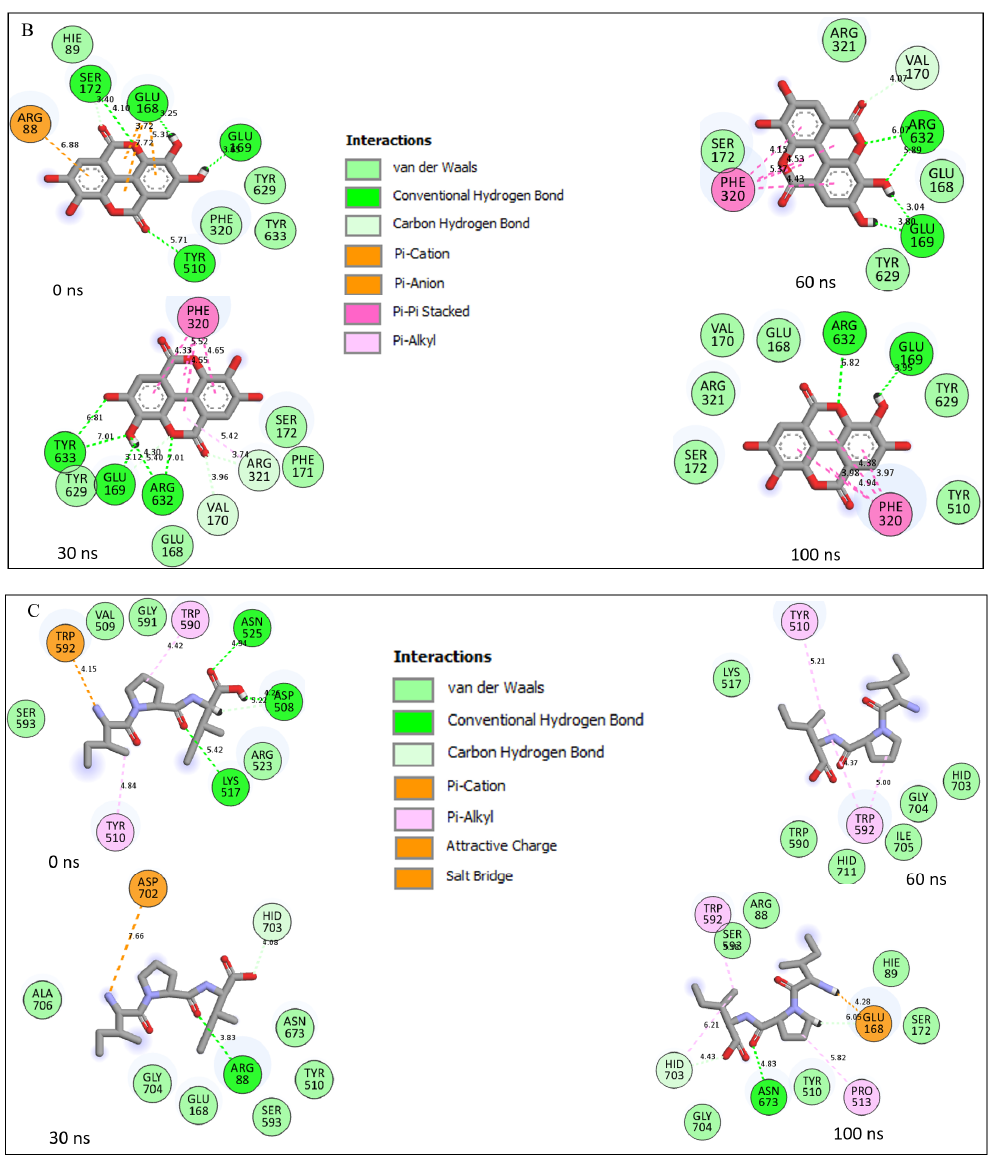
Figure 2. Interaction types and plots of ( A ) Chlorogenic acid–DPP-IV; ( B ) Ellagic acid–DPP-IV and ( C ) Diprotin A–DPP-IV at different time frame during a 100 ns simulation.